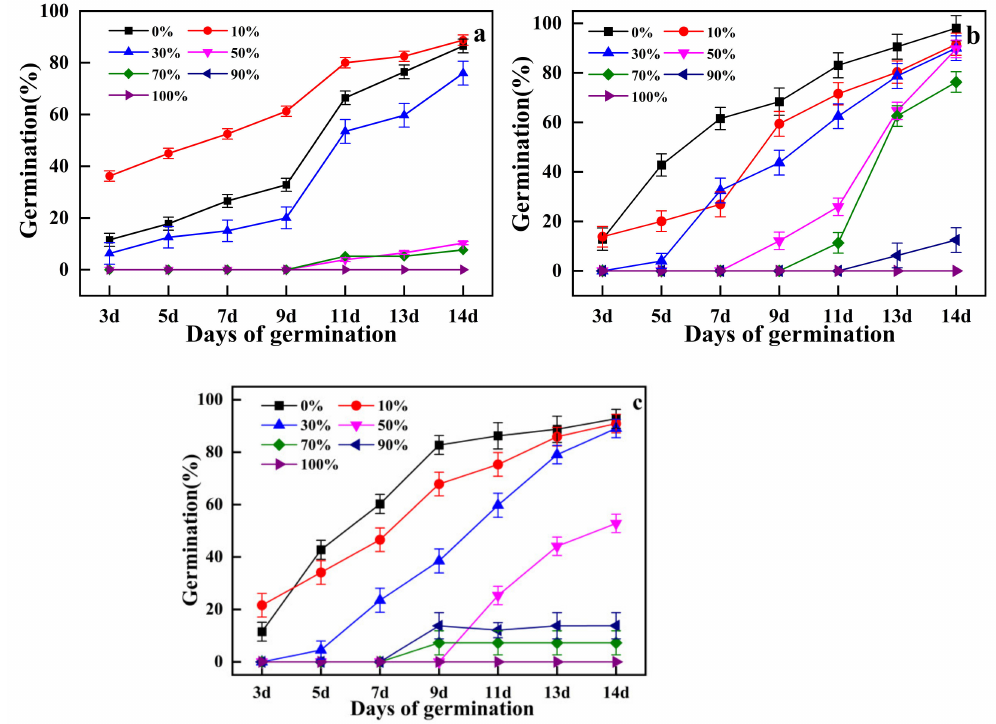
Figure 3. The 14-day germination percentage of mung beans in ( a ) pyrolytic residue; ( b ) thermal- washing residue; ( c ) high-temperature oxidation